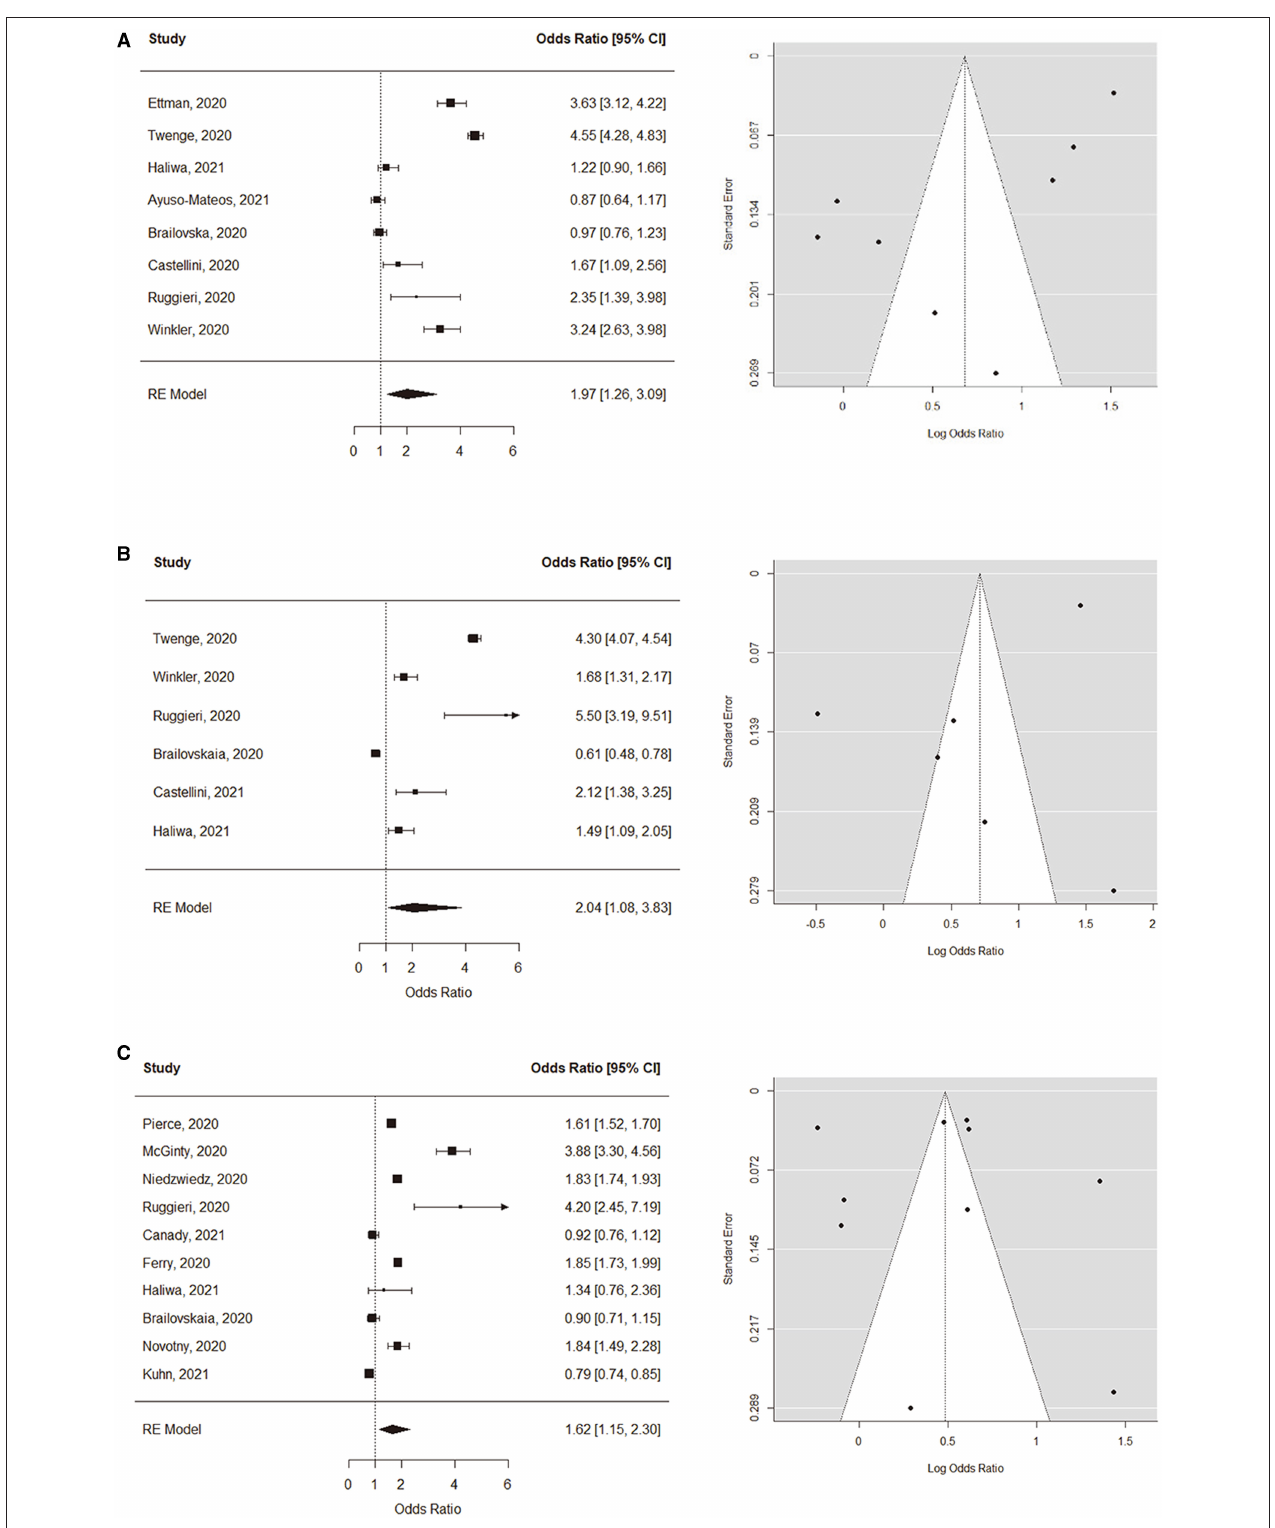
FIGURE 1 | Forest and funnel plots of symptom level comparisons. (A) Depression, (B) Anxiety, and (C) Psychological distress and stress.